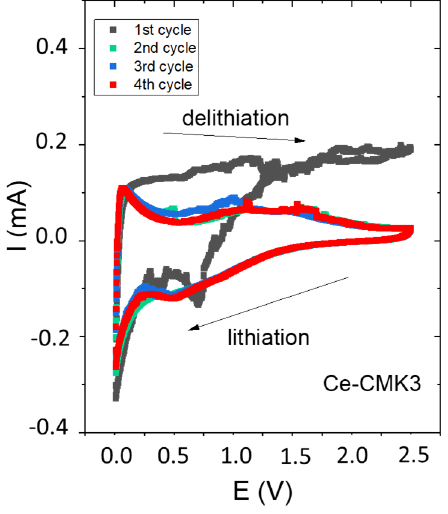
Figure 5. CV curves (from 1st to 4th cycles) for the Ce-CMK3 anode in the voltage range of 0.01–3.0 V vs. Li/Li + at 0.1 mV/s rate.